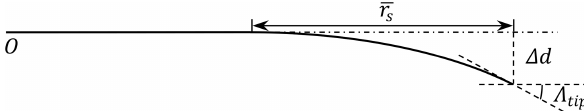
Figure 8. The parameterization of the dihedral blade with dihedral ratio r s , dihedral magnitude (cid:49)d and tip dihedral angle (cid:51) tip . The figure is from Li et al. (2018), but the definitions of the parameters are modified.